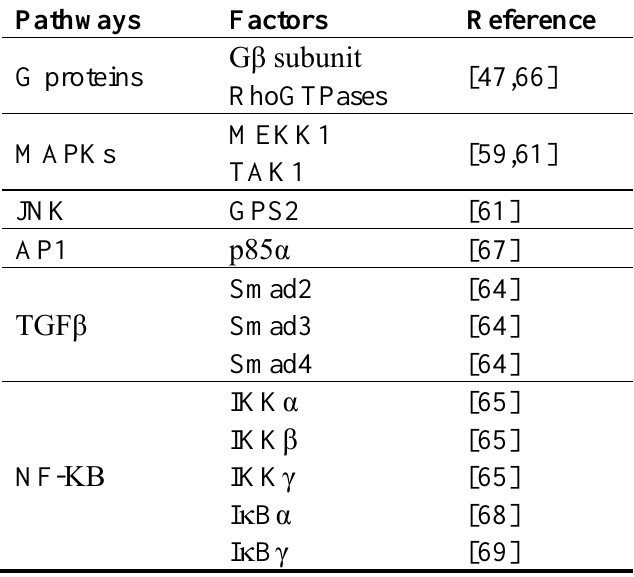
Table 1. Cell signaling factors interacting with